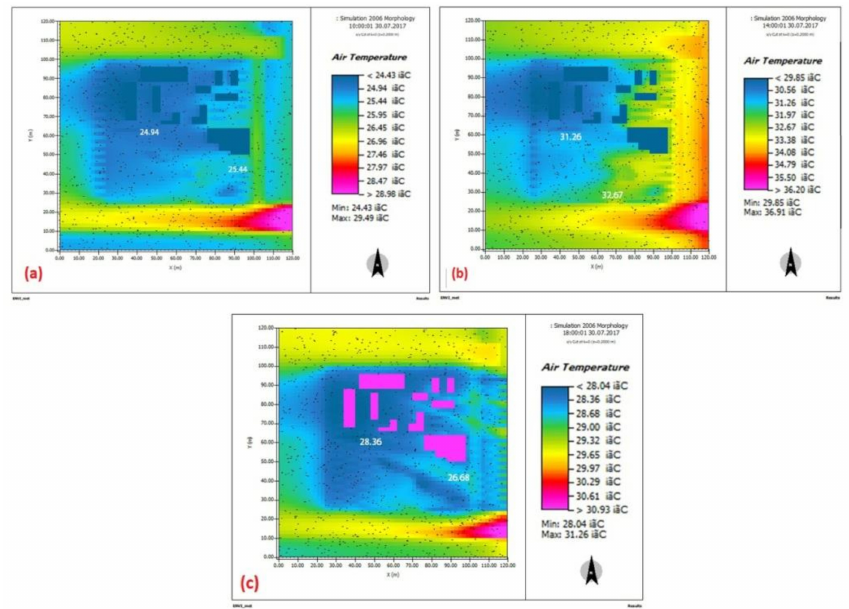
Figure 8. ENVI-met simulation outputs for T air at ( a ) 10:00; ( b ) 14:00; and ( c ) 18:00.